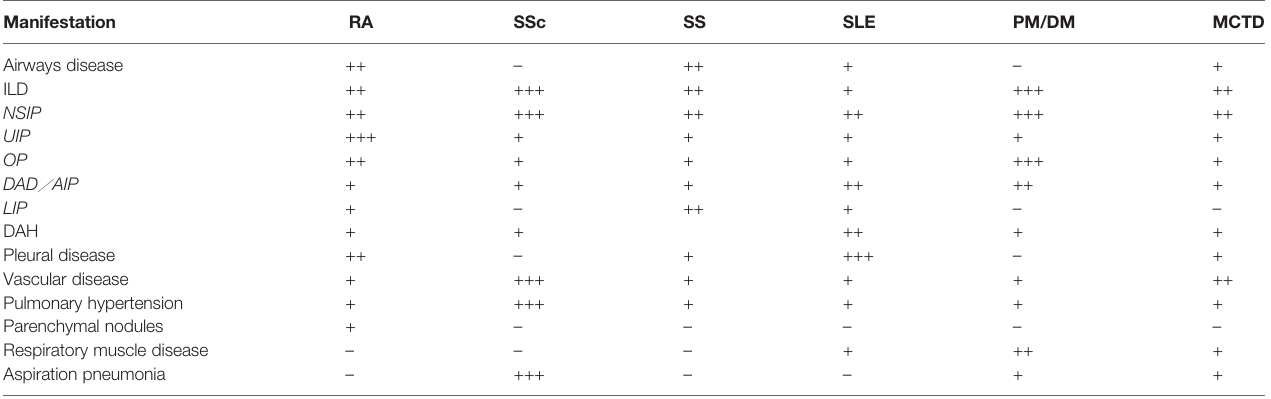
TABLE 2 | Characteristics of lung involvement in different